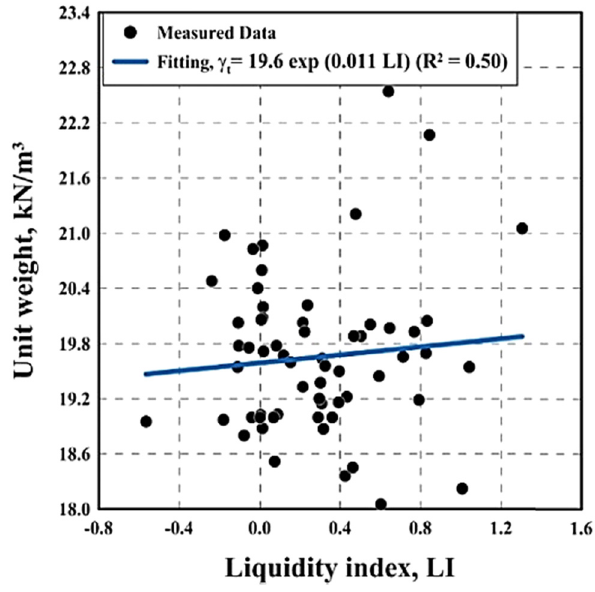
Figure 13: Unit weight versus LI